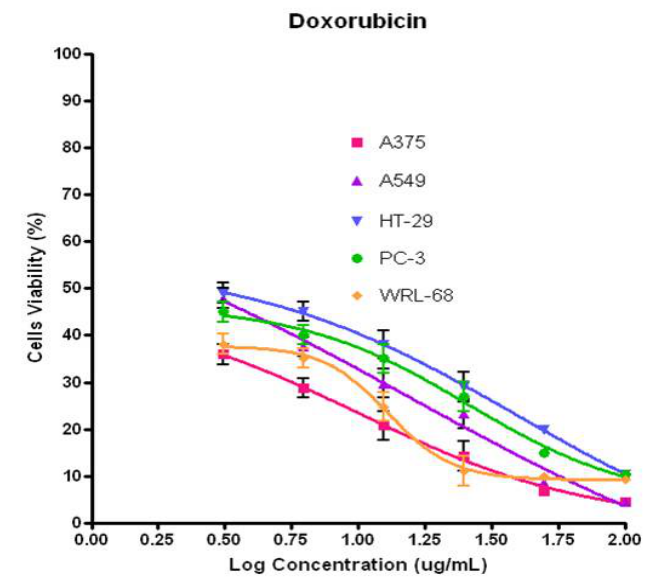
Figure 6. Dose-response curves (using GraphPad Prism) tested with doxorubicin